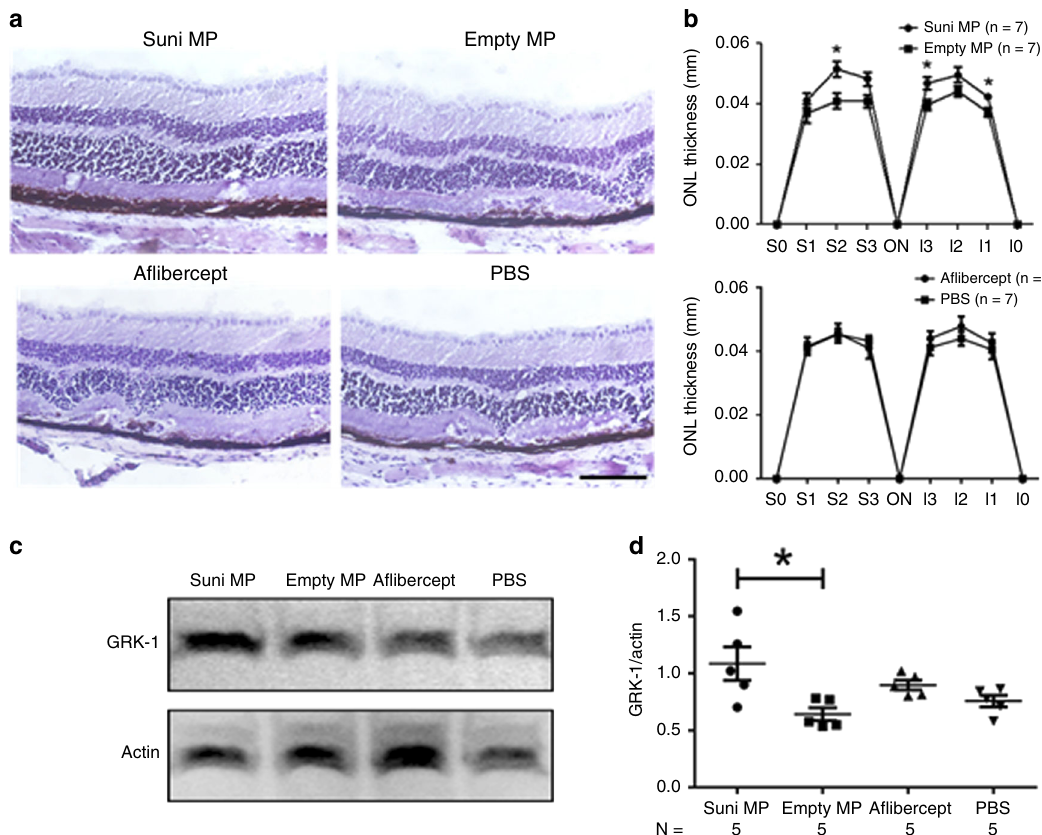
Fig. 5 Intravitreous injection of sunitinib MPs in mice with type 3 CNV reduces photoreceptor cell death. Rho/VEGF mice were given an intravitreous injection of 10 µ g of sunitinib microparticles (Suni MP) in one eye and 10 µ g of empty MP in the other eye or 40 µ g of a fl ibercept in one eye and PBS in the fellow eye. At P42, mice ( n = 7 for each group) were euthanized and serial frozen ocular sections were cut from the superior pole of the eye (S0) to the inferior pole (I0) and sections 25% (S1 and I1), 50% (S2 and I2), and 75% (S3 and I3) of the distance between each pole and the optic nerve (ON) were stained with hematoxylin and outer nuclear layer (ONL) thickness was measured by image analysis by a masked investigator. The ONL of sections from the S2 location of Suni MP-injected eyes appeared thicker than those from empty MP-injected eyes, but those from a fl ibercept-injected eyes appeared similar to those from PBS-injected eyes ( a scale bar = 100 µ m). The mean (±SEM) ONL thickness was signi fi cantly greater at three of six locations in Suni MP-injected eyes compared with empty MP-injected eyes, but there was no difference between a fl ibercept- and PBS-injected eyes ( b ). At P49, mice ( n = 5 for each group) were euthanized and immunoblots of retinal homogenates from Suni MP-injected eyes showed prominent bands for rhodopsin kinase (GRK-1) ( c ). Denistometry showed that the mean (±SEM) GRK-1/Actin ratio was signi fi cantly greater in retinas from Suni MP-injected eyes compared with empty MP-injected fellow eyes, but not a fl ibercept-injected eyes vs. PBS-injected fellow eyes ( d ). * p < 0.05 by Mann Whitney for difference from fellow eye empty MP control. Source data are provided as a Source Data fi